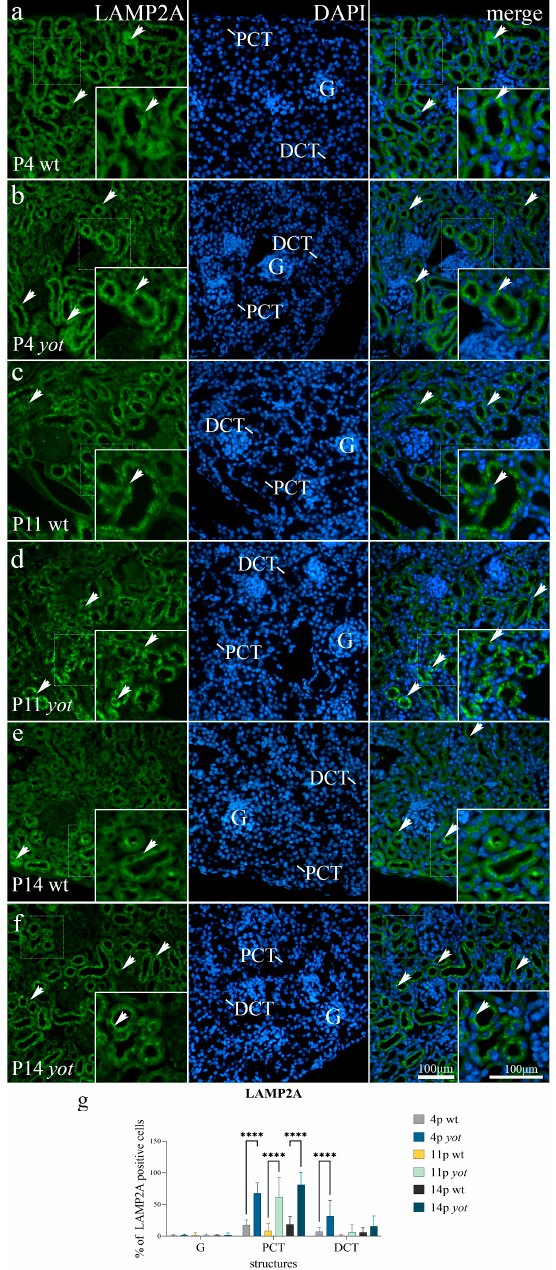
Figure 8. Immunofluorescence staining of postnatal wild-type (wt) ( a , c , e ) and yotari ( b , d , f ) mouse kidneys with LAMP2A marker and DAPI nuclear staining. Three mice were used for each genotype ( yotari and wt) at every observed time point. Arrows show the expression pattern of LAMP2A in glomeruli (G), proximal convoluted tubules (PCT), and distal convoluted tubules (DCT) indicated on the 4 (cid:48) ,6-diamidino-2-phenylindole (DAPI) image. The most prominent protein expression area is shown in the inserts, corresponding to the dashed boxes. Images were taken at a magnification of × 40. The scale bar is 100 µ m, which refers to all images. Graph ( g ) shows the distribution of the percentage of LAMP2A-positive cells in the glomeruli (G), proximal convoluted tubules (PCT), and distal convoluted tubules (DCT) of postnatal kidneys of wild-type and yotari animals over time (P4, P11, P14). Data are presented as the mean ± SD (vertical line) and analyzed by a two-way ANOVA test followed by Tukey’s multiple comparison test. Significant differences are indicated by **** p < 0.00001. At each time point, twenty substructures were